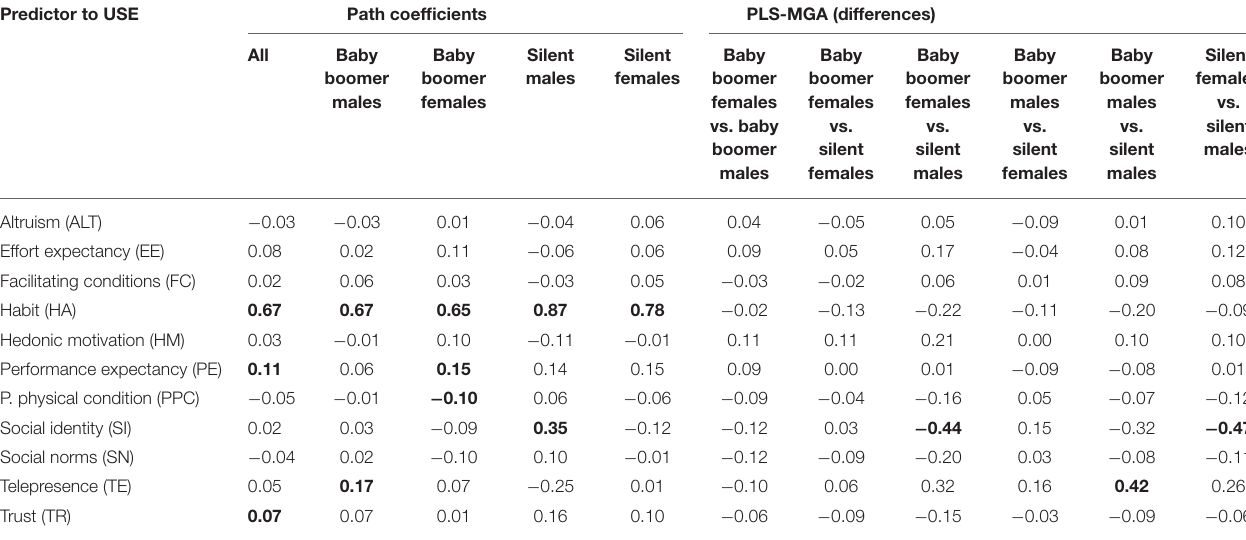
TABLE 4 | PLS-MGA results. Predictor to